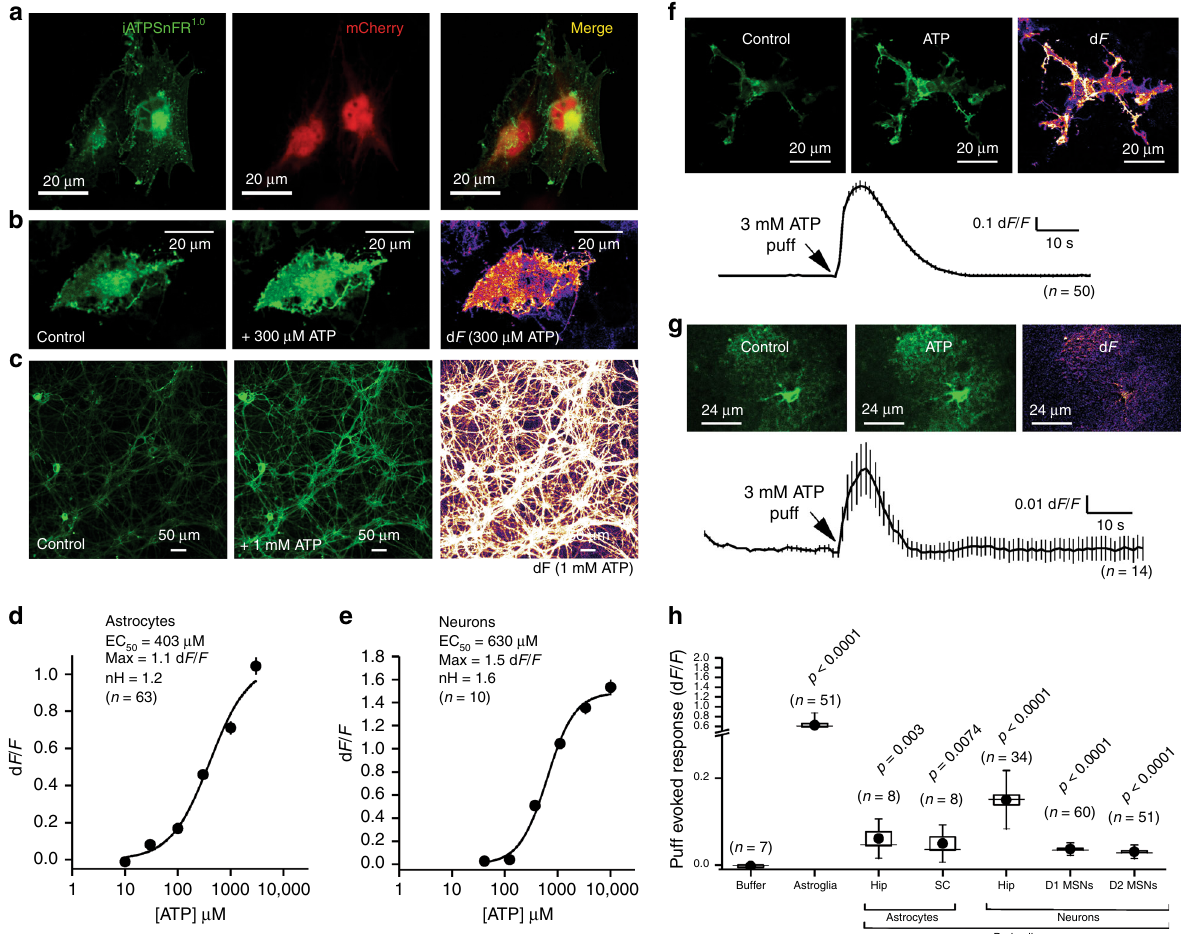
Fig. 5 Characterization of cell surface and cytosolic iATPSnFR 1.0 in astrocytes and neurons. a A single plane from a confocal z-stack of a U373MG cell expressing cytoplasmic mCherry and membrane-displayed iATPSnFR 1.0 . b Confocal images of U373MG cells expressing iATPSnFR 1.0 before ATP application (control) and during a 300 µ M ATP application ( + ATP), as well as the change in fl uorescence (d F ). c Confocal images of hippocampal neurons before ATP application (control) and during 1 mM ATP application, as well as the change in fl uorescence (d F ). d , e Dose – response curves for iATPSnFR 1.0 when displayed on the surface of U373MG astroglia and hippocampal neurons. f A confocal image of a U373MG astroglia cell transfected with iATPSnFR 1.0 before a 3 mM puff of ATP (control), during the puff (ATP), as well as the change in fl uorescence (d F ). An average trace from all cells with the s.e.m. is also shown. g Representative hippocampal astrocyte in acute brain slice expressing iATPSnFR 1.0 before the application of ATP (control), during the application of 3 mM ATP (ATP), and the dF. An average trace from all cells with the s.e.m. is also shown. h Scatter graph summary of the effect of 3 mM ATP on iATPSnFR 1.0 expressed in the cell types indicated. In panel ( h ), the circle represents the mean, the box the s.e.m., the whiskers the s.d., and the horizontal line the median. p Values are shown for statistical comparisons to the buffer puff control using un-paired Student ’ s t tests. Abbreviations: hip hippocampus, SC spinal cord, MSNs medium spiny neurons. Note broken y -axis. In other panels, the error bars represent the s.e.m. and in some cases are smaller than the symbols used for the mean. n numbers are provided in the fi gure panels and refer to the number of